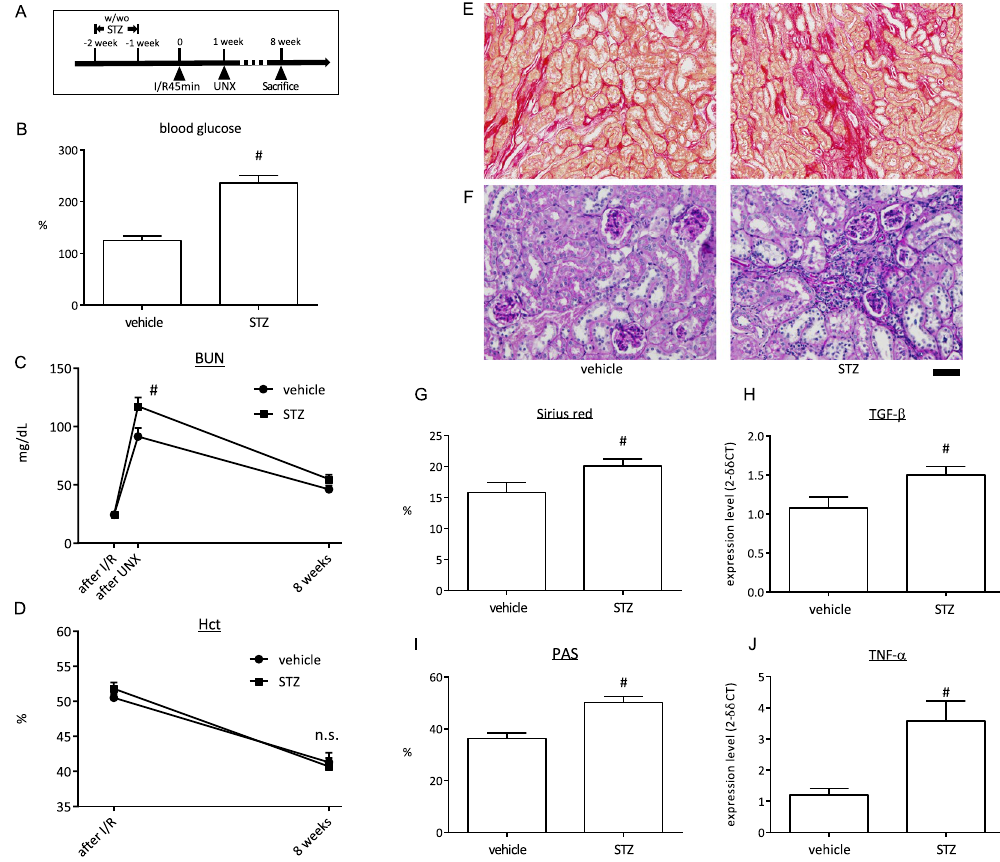
Figure 4. Assessment of influence by hyperglycaemia. ( A ) Schematic of the experiment schedule. ( B–D ) The level of blood glucose ( B ), BUN ( C ), and Hct ( D ) in the control and STZ-treated mice that were subjected to 45-min ischaemia/reperfusion (I/R) and then uninephrectomy (UNX) 1 week later (n = 7). Blood sampling for the “after I/R” or “UNX” was performed at 24 hours after each procedure. ( E , F ) Representative images of Sirius red and PAS staining in the control and STZ-treated mice. Scale bar = 100 µ m for Sirius red and 50 µ m for PAS. ( G ) Semi-quantitative analysis of Sirius red staining in the renal cortex. ( H ) Quantification of TGF- β expression in the kidney. ( I ) Semi-quantitative analysis of PAS staining in the renal cortex. ( J ) Quantification of TNF- α expression in the kidney. # p < 0.05 vs. vehicle; ns, no